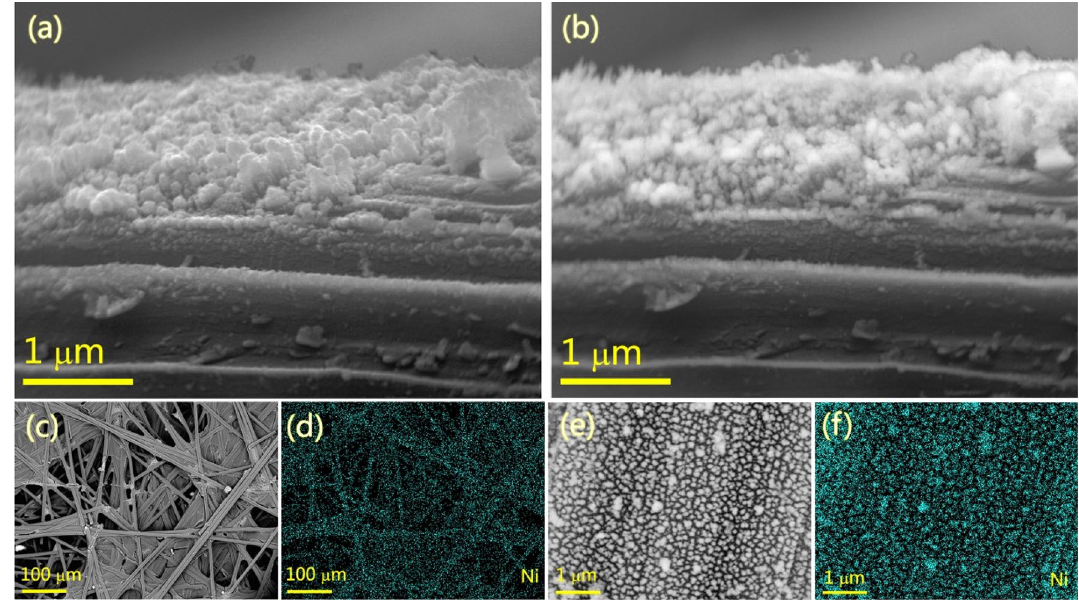
Fig. 5 a Side-view secondary electron image and b back-scattered electron image of the deposited Ni nanoparticles for 12-Ni/CP. c Low magnification secondary electron image and elemental mapping